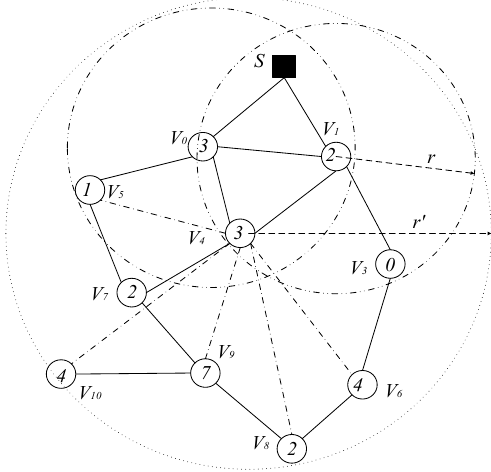
Figure 7. The network topology after increasing the radius.